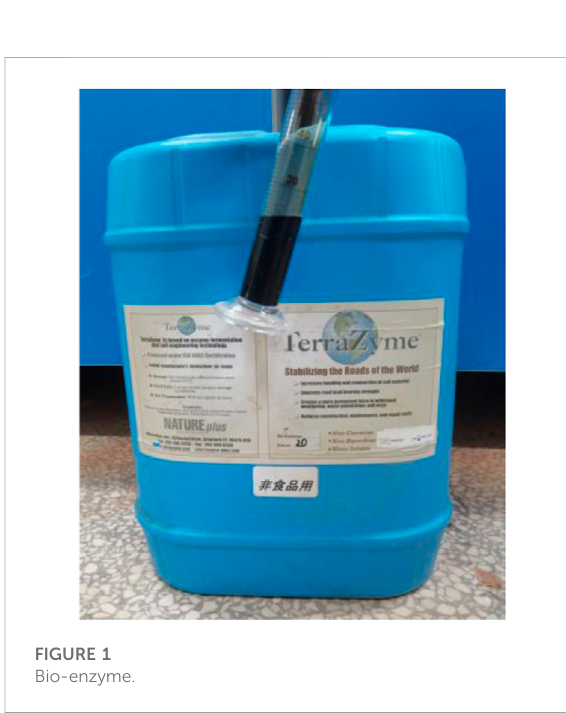
FIGURE 2 WG single lever consolidation